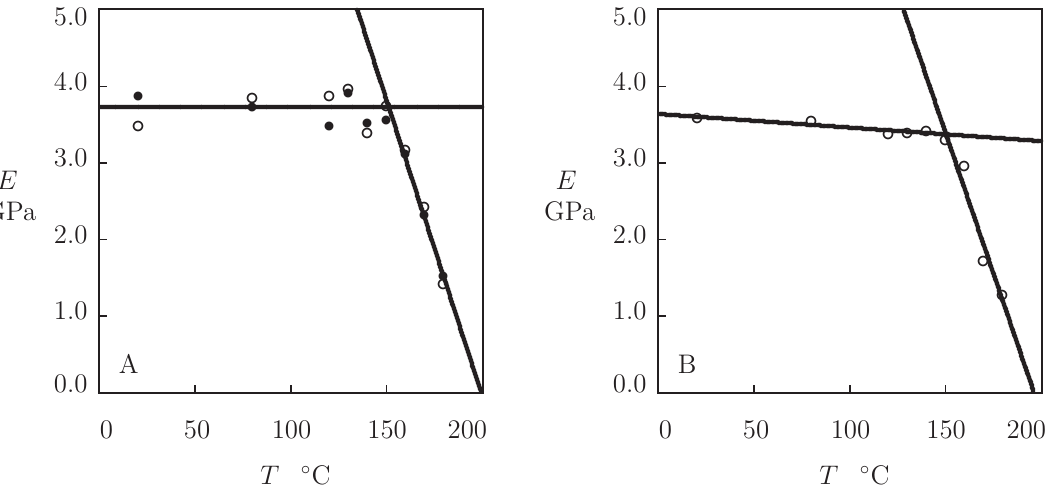
Figure 7. The Young’s modulus E versus temperature T . Symbols: ( A )—treatment of observations in tensile tests ( creep tests ( ). ( B )—treatment of observations in relaxation tests. Solid lines: approximation of the data by Equation •